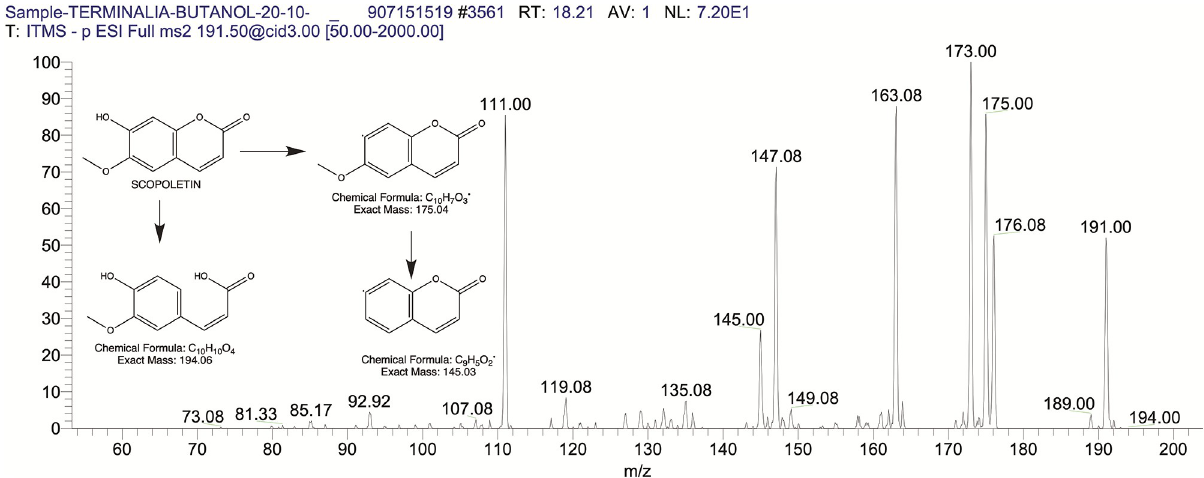
Fig 20. The mass spectrum of scopoletin and its fragmentation